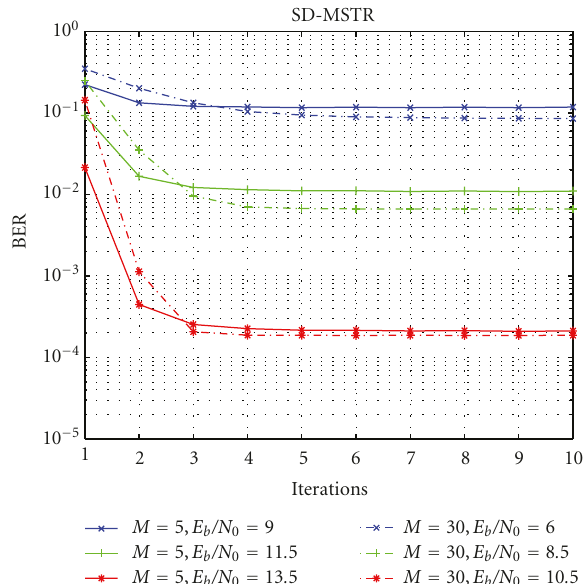
Figure 6: Convergence rate of SD-MSTR with M = 5, 30 in di ff erent SNR level.